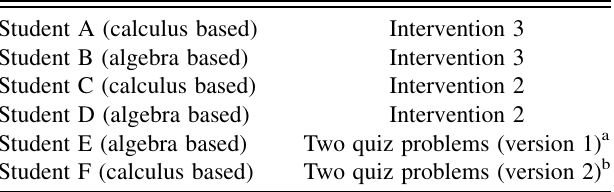
TABLE V. The interventions students received in the inter-